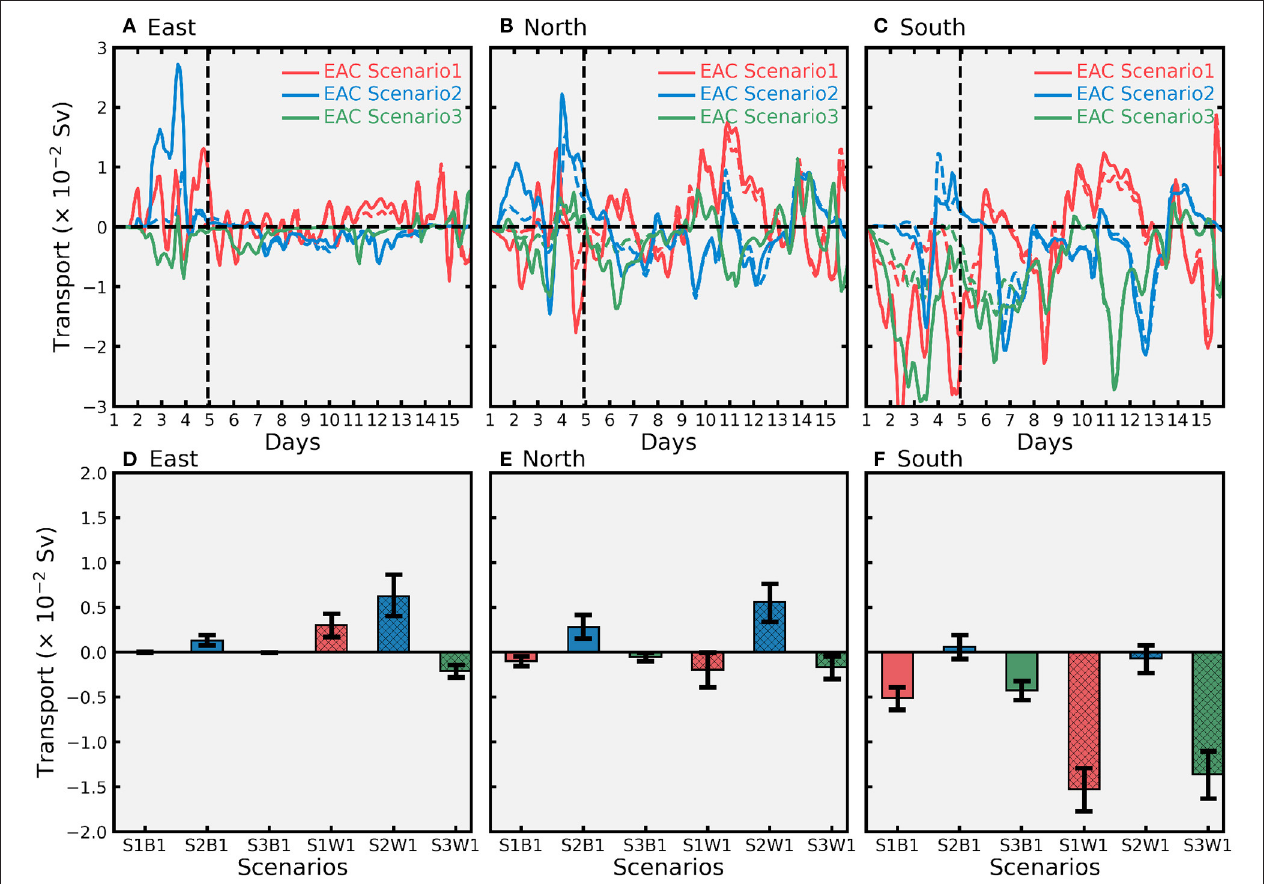
FIGURE 10 | Time series of freshwater transport to the north, south and east for each EAC scenario in the base case and wet event during the whole simulation period. (A) Time series of freshwater transport along the east side of the purple box in Figures 4 , 6 . The solid (dashed) red, blue, and green lines indicate EAC scenario 1, EAC scenario 2, EAC scenario 3 in the wet event (base case), respectively. (B,C) Same as (A) , but for the north and south side of the box. (D) Freshwater transport averaged within the first 4 days for the base case (unhatched bars) and wet event (hatched bars). (E,F) Same as (D) , but for the north and south side of the